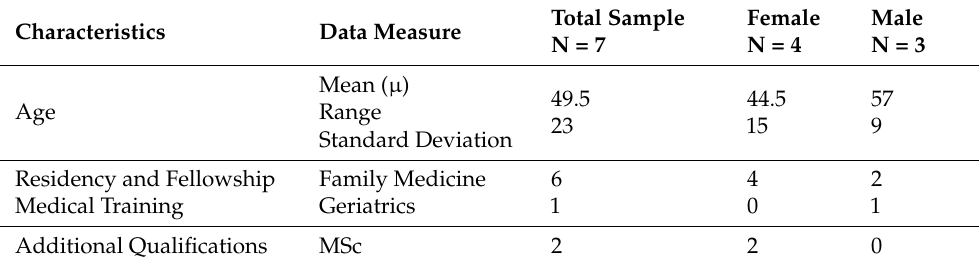
Table 2. Family physician participant